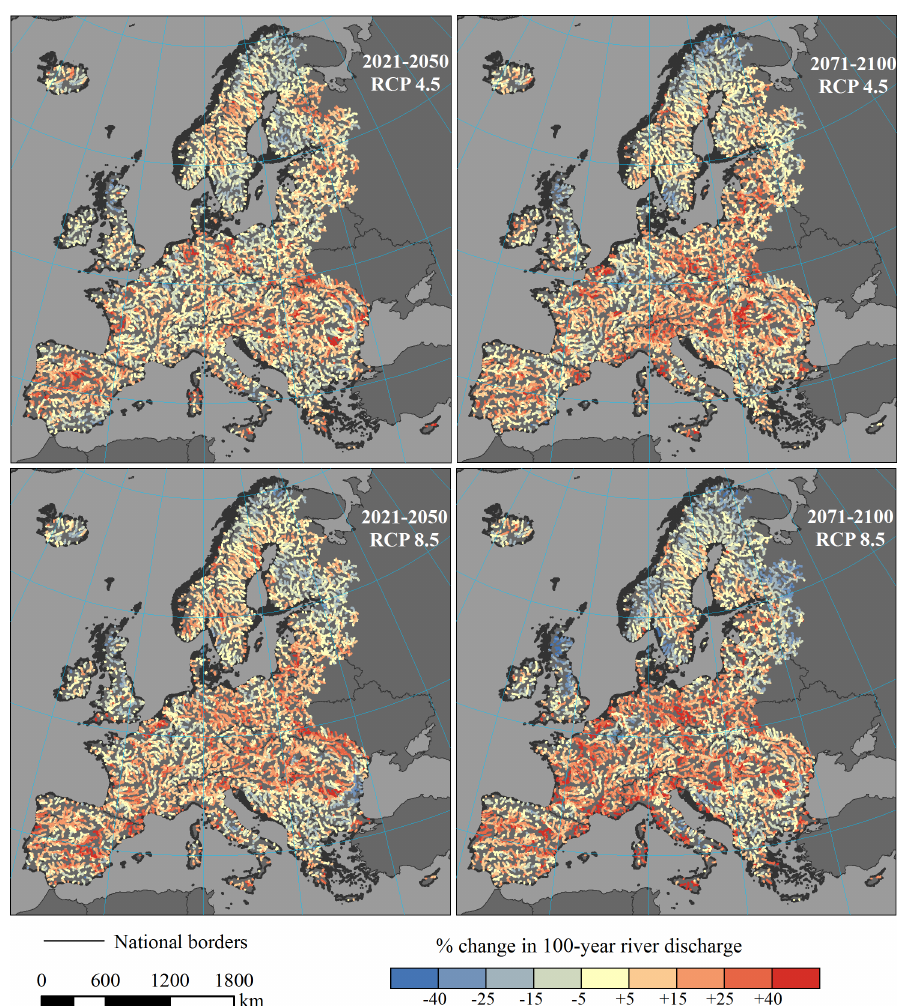
Figure 8. Predicted trends in daily river discharge with a 100-year return period (Gumbel distribution) under climate-change scenarios RCP 4.5 and RCP 8.5 (rivers with catchment area above 500km 2 only). Projections based on EC-EARTH-COSMO_4.8_clm17 climate model